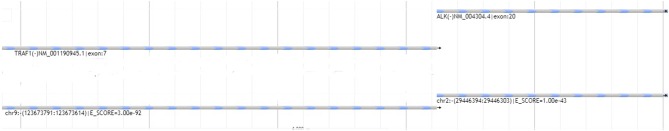
Graphical representation of next-generation sequencing translocation analysis. Reads aligned with exon 20 of ALK1 were found to be adjacent with reads aligned with exon 7 of the TRAF1 gene. E-score represents a confidence score whereby lower values reflect higher confidence of sequence alignment in the reads.